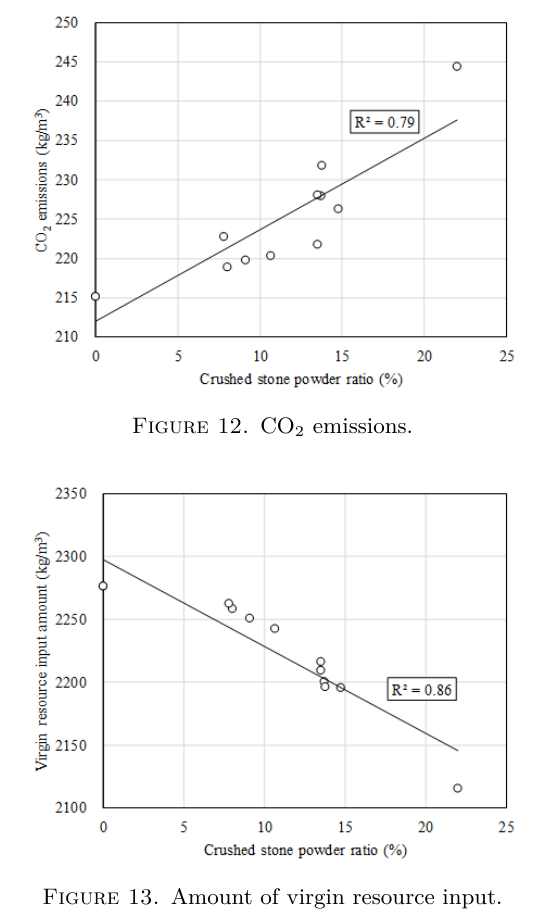
Figure 13. Amount of virgin resource input.